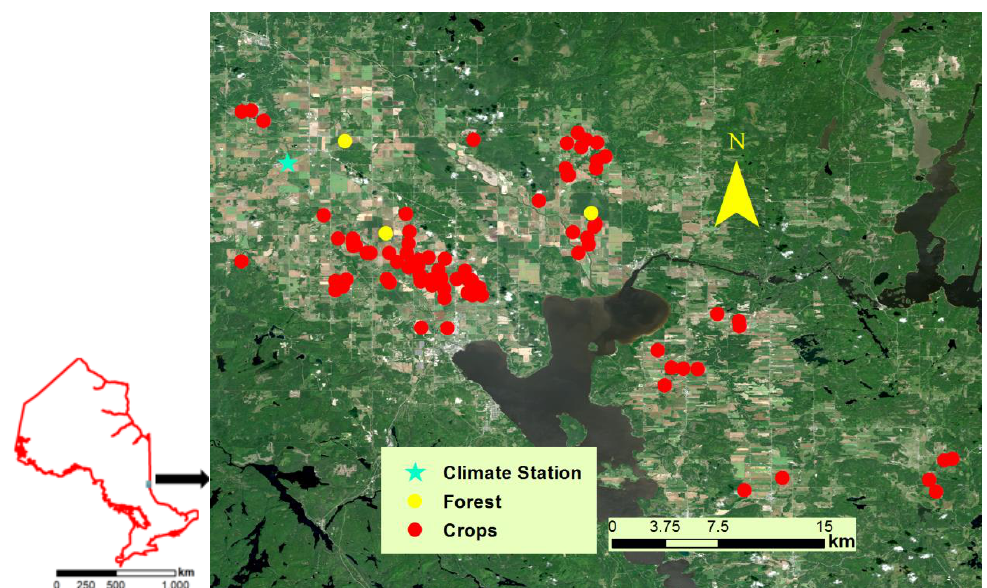
Figure 1. Study area in Temiskaming Shores, northern Ontario, overlaid with observed crop fields and forest. Background is a Landsat image acquired on August 24, 2019. Remote Sens. 2020 , 12 , x FOR PEER REVIEW Table 1. Number of fields observed for 2019 growing season (n = 84) .